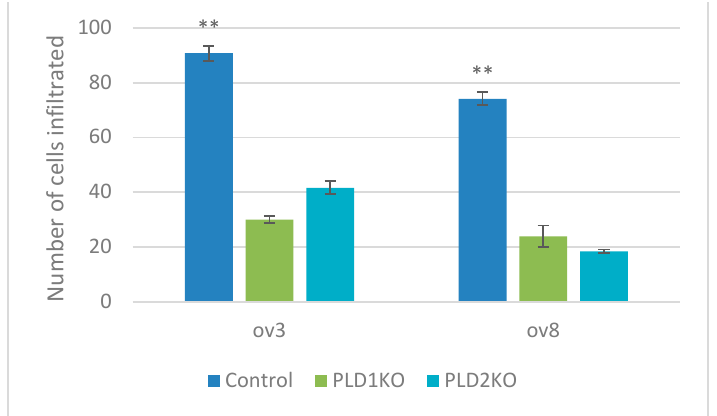
Figure 2. PLDs silencing affects invasion in OC cells. Transwell invasion assay to test the effect of PLDs on invasive activity. Average number of migrated cells is represented. Both KOs reduced invasion in both OVCAR3 and OVCAR8 cells (** p < 0.01, n = 6). Error bars represent SEM.